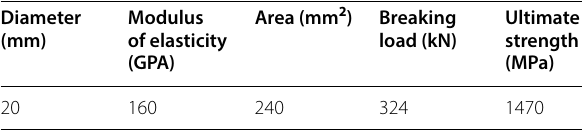
Table 3 Material properties of